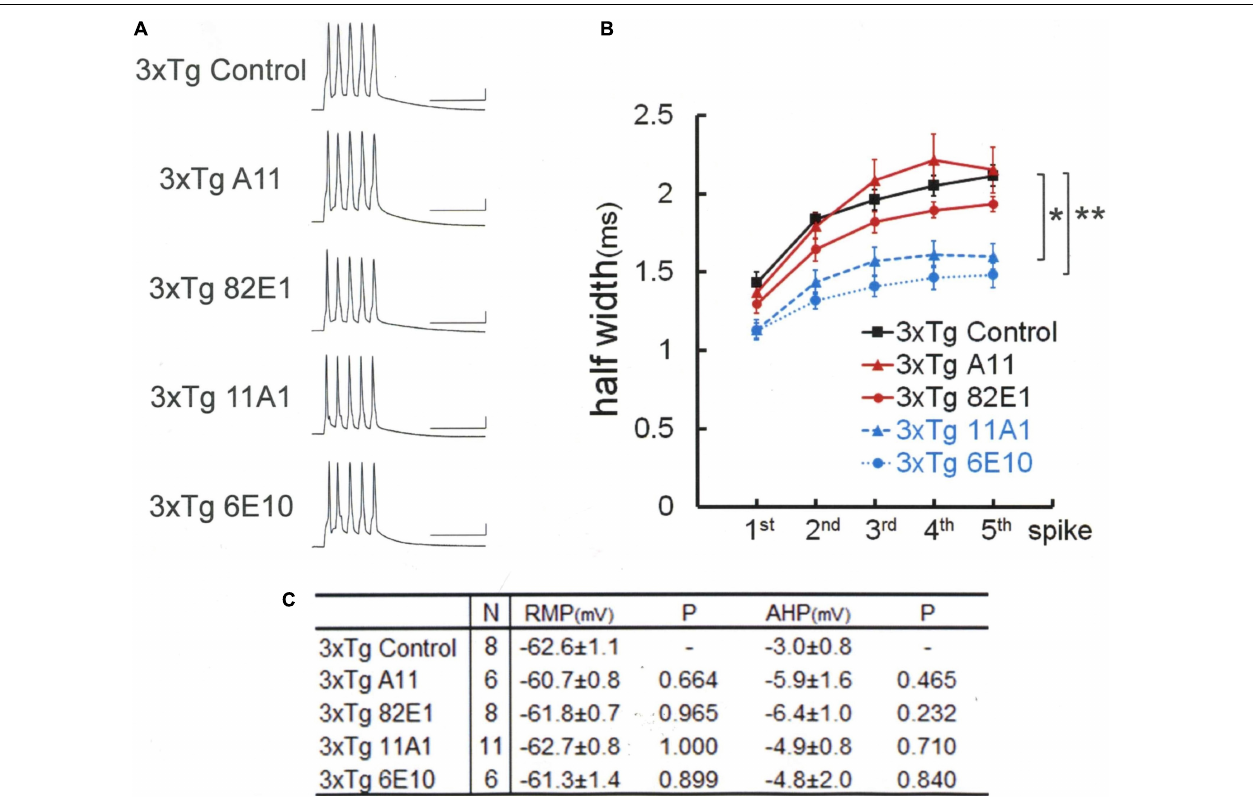
FIGURE 2 | An A β -oligomer antibody (11A1) or 6E10 prevented spike broadening in 3xTg mouse neurons. (A) Specimen recordings of spike trains under the injection of anti-A β oligomer antibodies. Scale bars, 50 ms and 20 mV. (B) Averaged spike half-width during the five-spike train (black solid line and square, 3xTg Control; red solid line and triangle, 3xTg A11; red solid line and circle, 3xTg 82E1; blue dashed line and triangle, 3xTg 11A1; blue dotted line and circle, 3xTg 6E10). With 11A1 and 6E10, spike half-widths in 5th spikes were significantly smaller than in 3xTg Control (* P = 0.001, ** P < 0.001). Note that 6E10 is reactive to a 16-amino-acid sequence common to A β , APP, and some APP C-terminal fragments. For the “3xTg Control” specimen recording and numerical data, those shown in Figure 1 are reproduced for clarity in this and following figures. (C) Basic membrane properties of recorded neurons. Convention is the same as in Figure 1